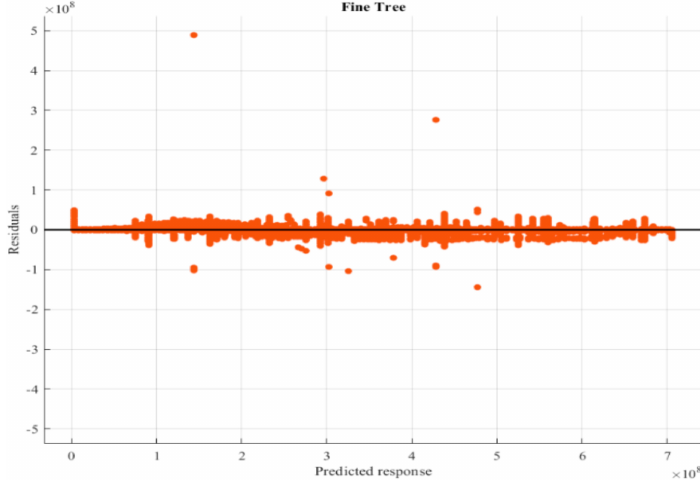
Figure 11. Fine Trees Residual training.